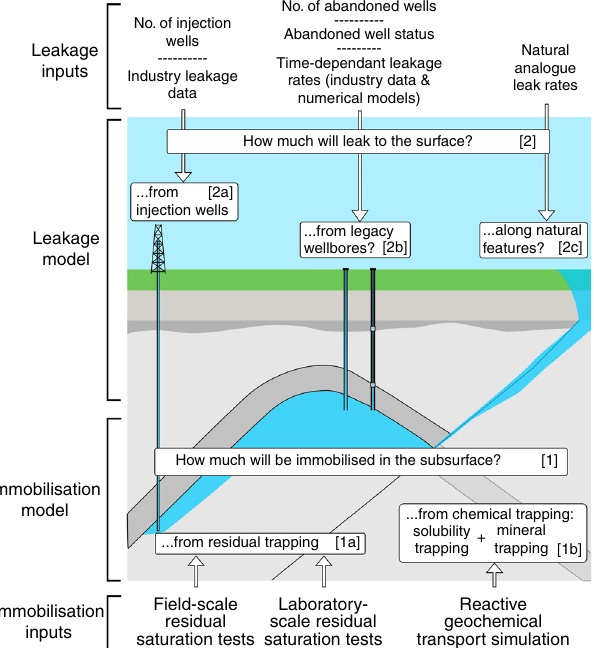
Fig. 1 The Storage Security Calculator concept. The CO 2 immobilisation model [1] combines two sub-models: [1a] residual trapping, and [1b] chemical trapping (de fi ned as a combination of solubility and mineral trapping). The CO 2 leakage model [2] combines three sub-models: [2a] leakage through active (injection) wells, [2b] abandoned wells, and [2c] leakage via natural pathways. The key input parameters for each sub-model are